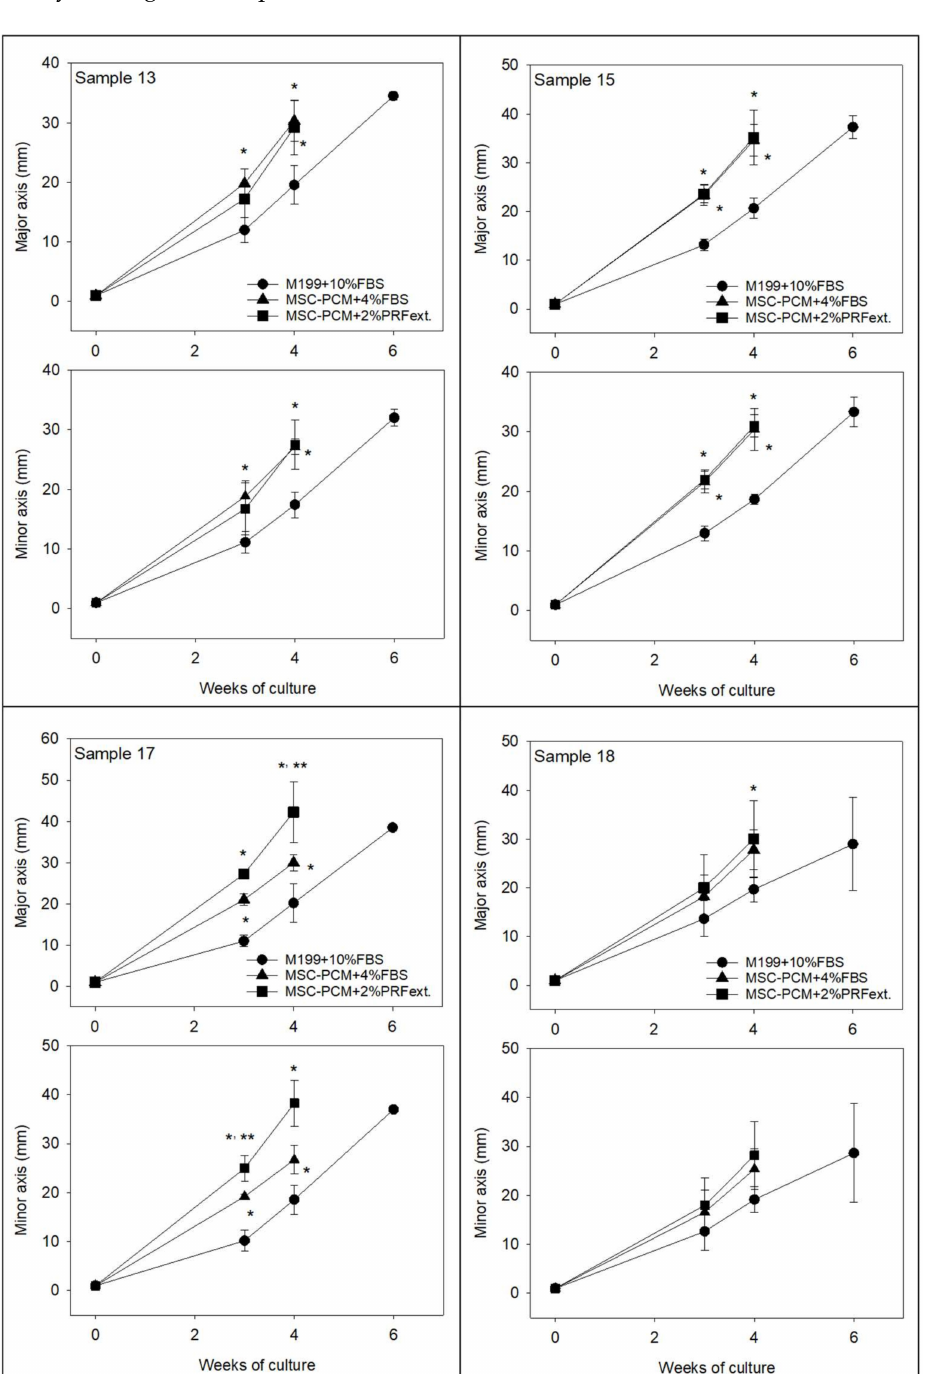
Figure 3. Effects of different culture media on the growth of periosteal sheets. The data obtained from periosteum samples derived from four independent donors are shown. X -axis: time periods (weeks) of explant culture. N = 2 (6 weeks), 3 (6 weeks), 4, 5, or 7 replicates. Statistical analysis was performed by Kruskal–Wallis one-way analysis of variance, followed by Steel–Dwass multiple comparison test. * p < 0.05 as compared with the control group (Medium199 + 10% FBS) at same time points. ** p < 0.05 as compared with the other experimental group (MSC-PCM + 4% FBS) at same time